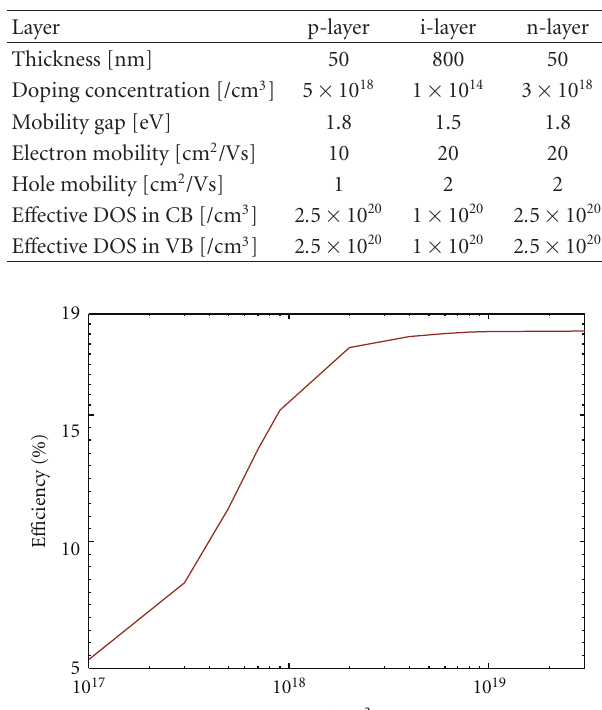
Table 1: The set of input parameters used in the simulation.